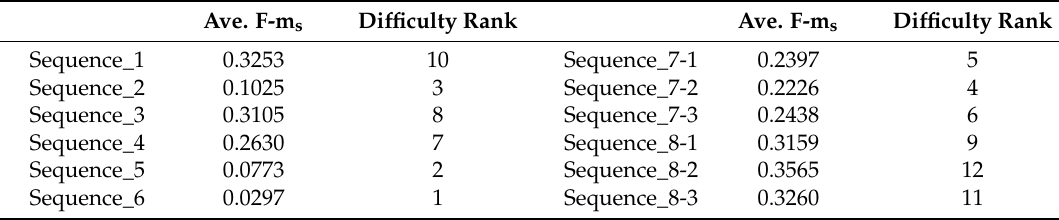
Table 11. Rank of difficulty that each IR video sequence poses to the evaluated BS